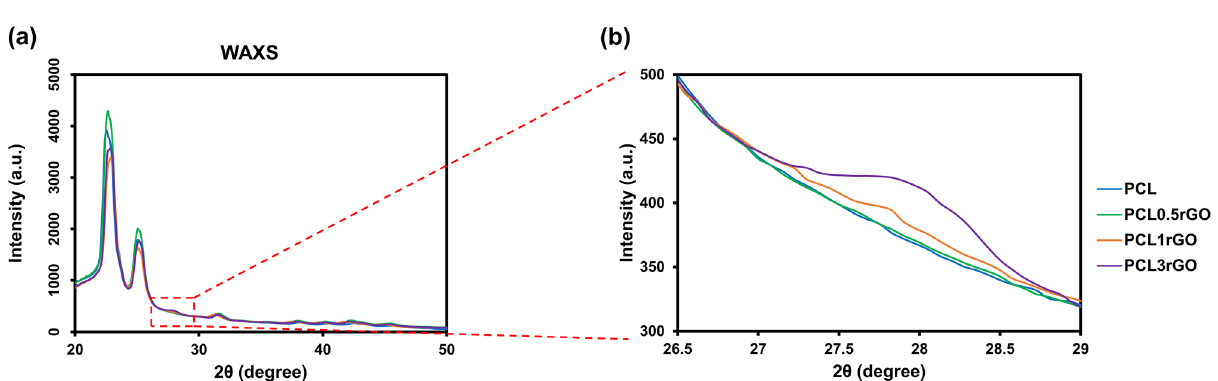
Figure 7. Sub-nanometer level structural analysis of the 3D printed PCL-rGO scaffolds. ( a ) The WAXS patterns of the 3D printed scaffolds. ( b ) The enlarged region of the WAXS pattern indicating the characteristic peak of graphite which corresponds to the aggregation and re-stacking of the graphenic